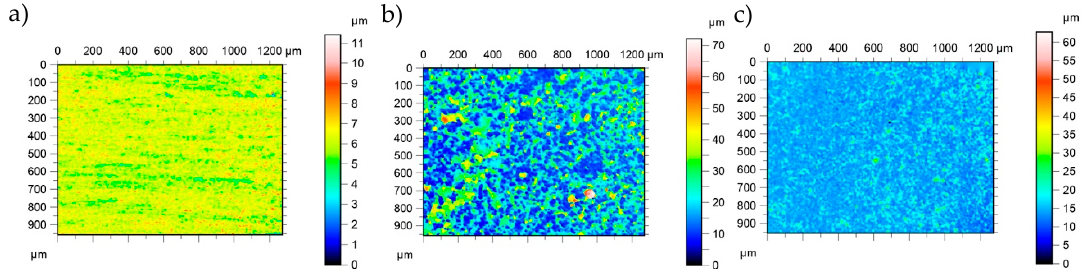
Figure 12 . RMS values measured by optical confocal microscopy are aluminum substrate ( a ) 0.52 ± 0.16 μ m; superhydrophobic surface ( b ) 8.59 ± 0.39 μ m and after 10 cycles of abrasion test ( c ) 2.99 ± 0.76 μ m. The EDP process increases the roughness while the abrasion test reduces it.